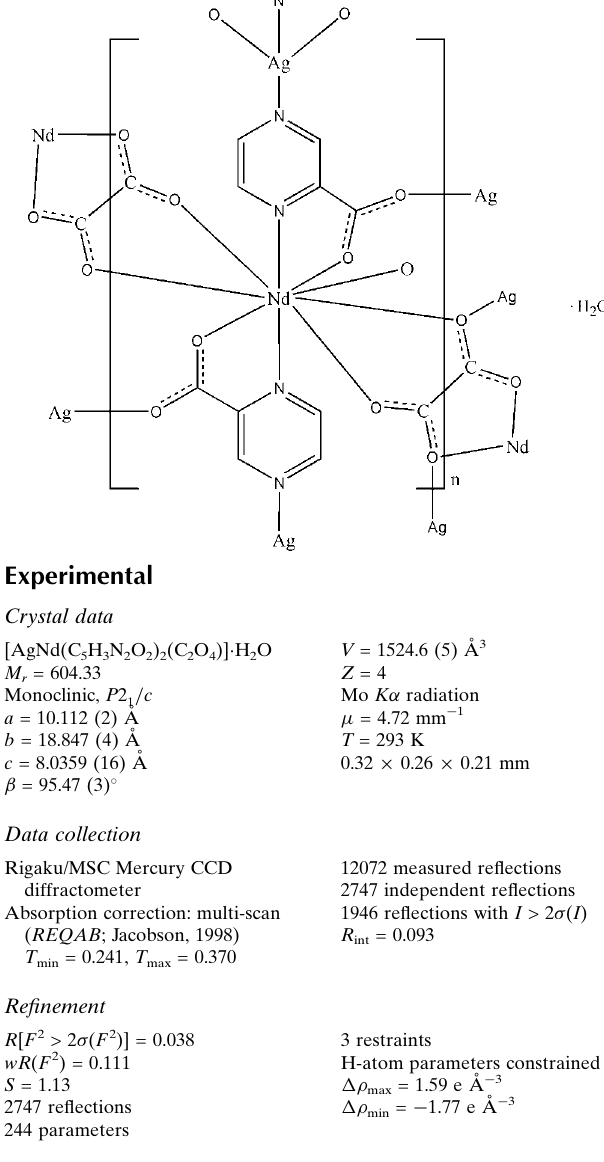
Data collection